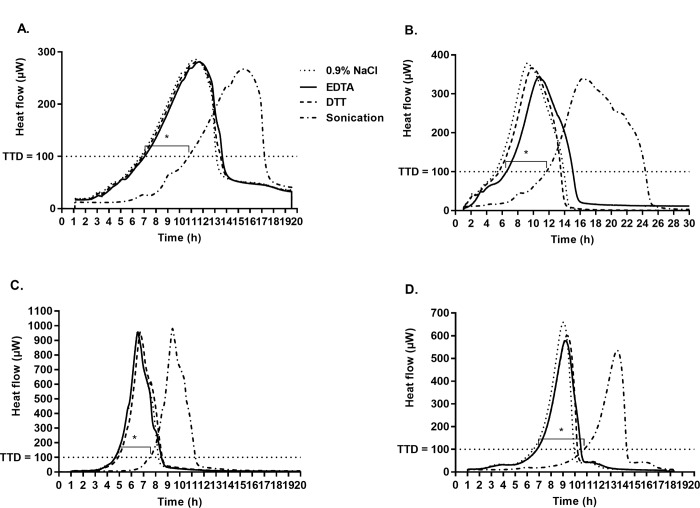
The microcalorimetric time to detection (TTD) of bacterial growth.(A) S. epidermidis biofilm. (B) S. aureus biofilm. (C) E. coli biofilm. (D) P. aeruginosa biofilm. 0.9% NaCl represents an untreated control. EDTA, ethylenediaminetetraacetic acid. DTT, dithiothreitol.TTD, the calorimetric time to detection of microbial heat production. * Statistically significant difference (p < 0.05).